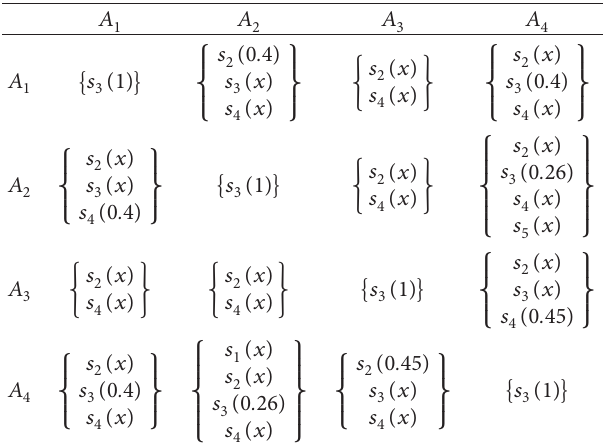
Table 1: The hesitant fuzzy incomplete probabilistic linguistic preference